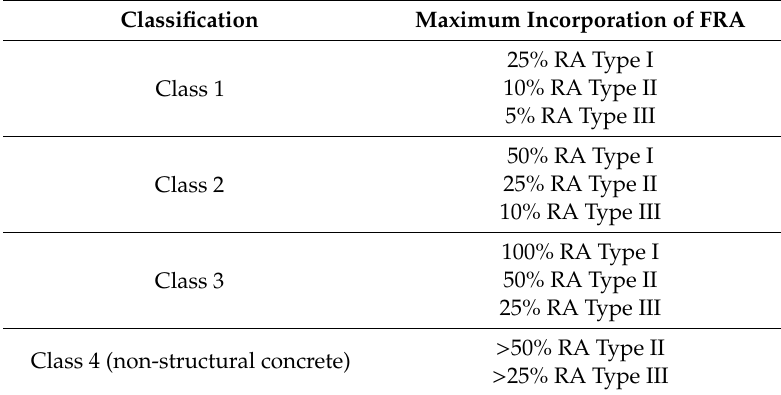
Table 5. Maximum incorporation ratios of FRA for each class.